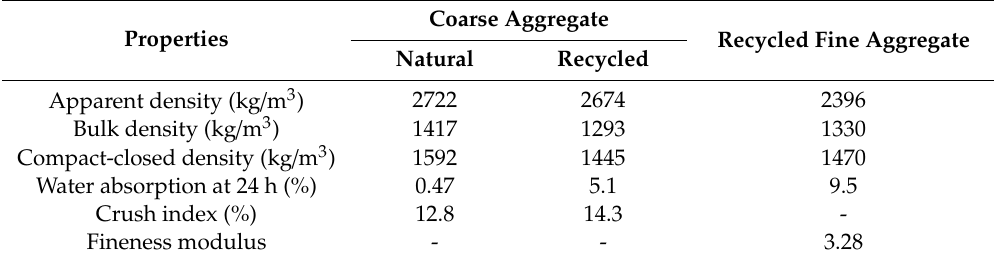
Table 1. Physical and mechanical properties of fine and coarse aggregates.